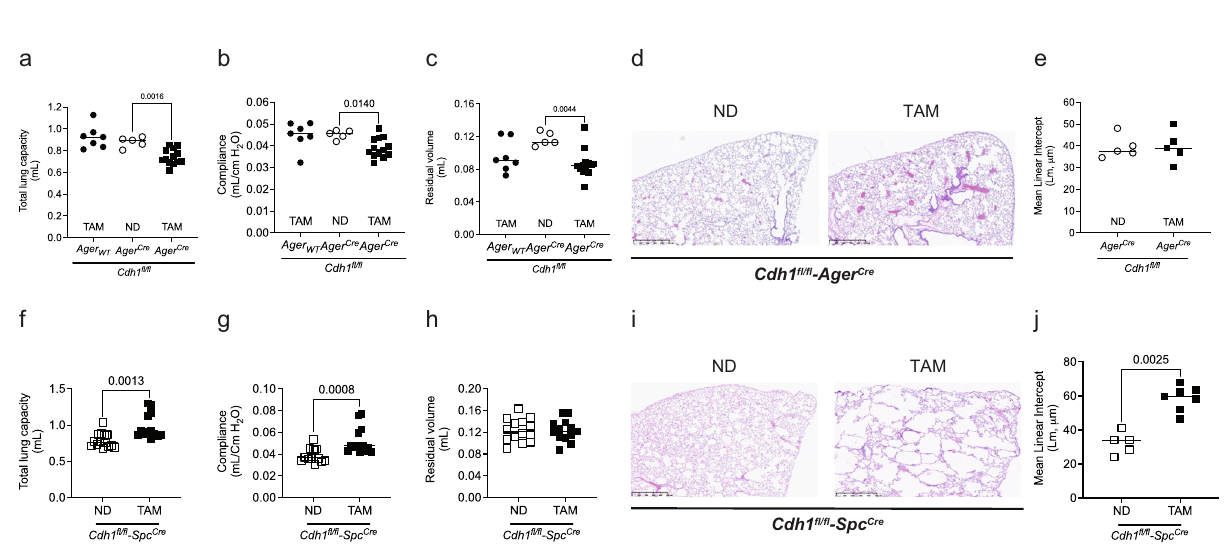
Fig. 2 In vivo E-cadherin knockdown in the alveolar type, I (AT1) and alveolar type II (AT2) cells have differential effects on mouse lung function and histology. To knock down E-cadherin in the AT1 cells of mice lungs, Cdh1 fl / fl -Ager Cre mice were fed a tamoxifen diet (TAM) for 1 month. These were compared to Cdh1 fl / fl -Ager Cre mice receiving a normal chow diet (ND) and Cdh1 fl / fl -Ager WT receiving TAM control mice. a Total lung capacity, b compliance, and c residual volume were decreased in E-cadherin knockdown in AT1 cells of mice lung. No difference in lung histology was observed by d H & E staining (representative image at 5X with a scale bar of 500 µ m) and e quanti fi ed mean linear intercepts (Lm) after E-cadherin knockdown in AT1 cells. To knock down E-cadherin in the AT2 cells of mice lungs, Cdh1 fl / fl -Spc Cre mice were fed TAM for 1 month. These were compared to Cdh1 fl / fl -Spc Cre , mice